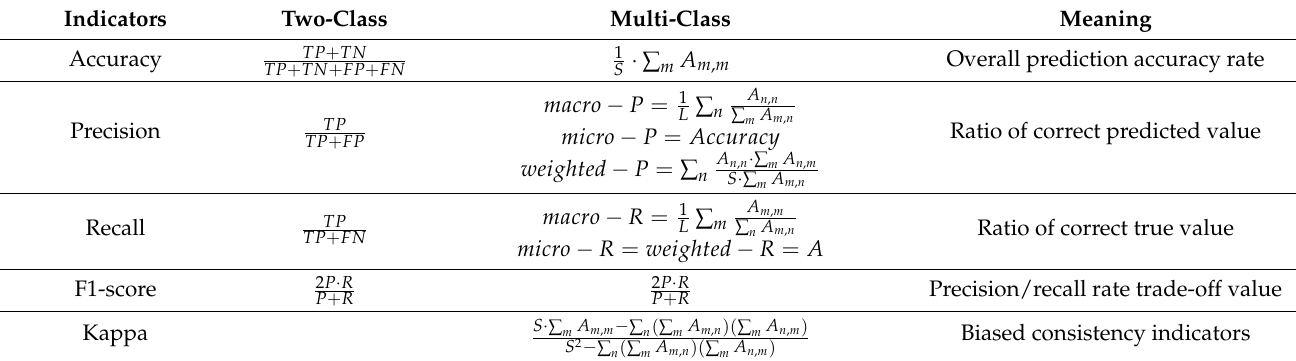
Table 3. The expression and meaning of the numerical indicators of the classification